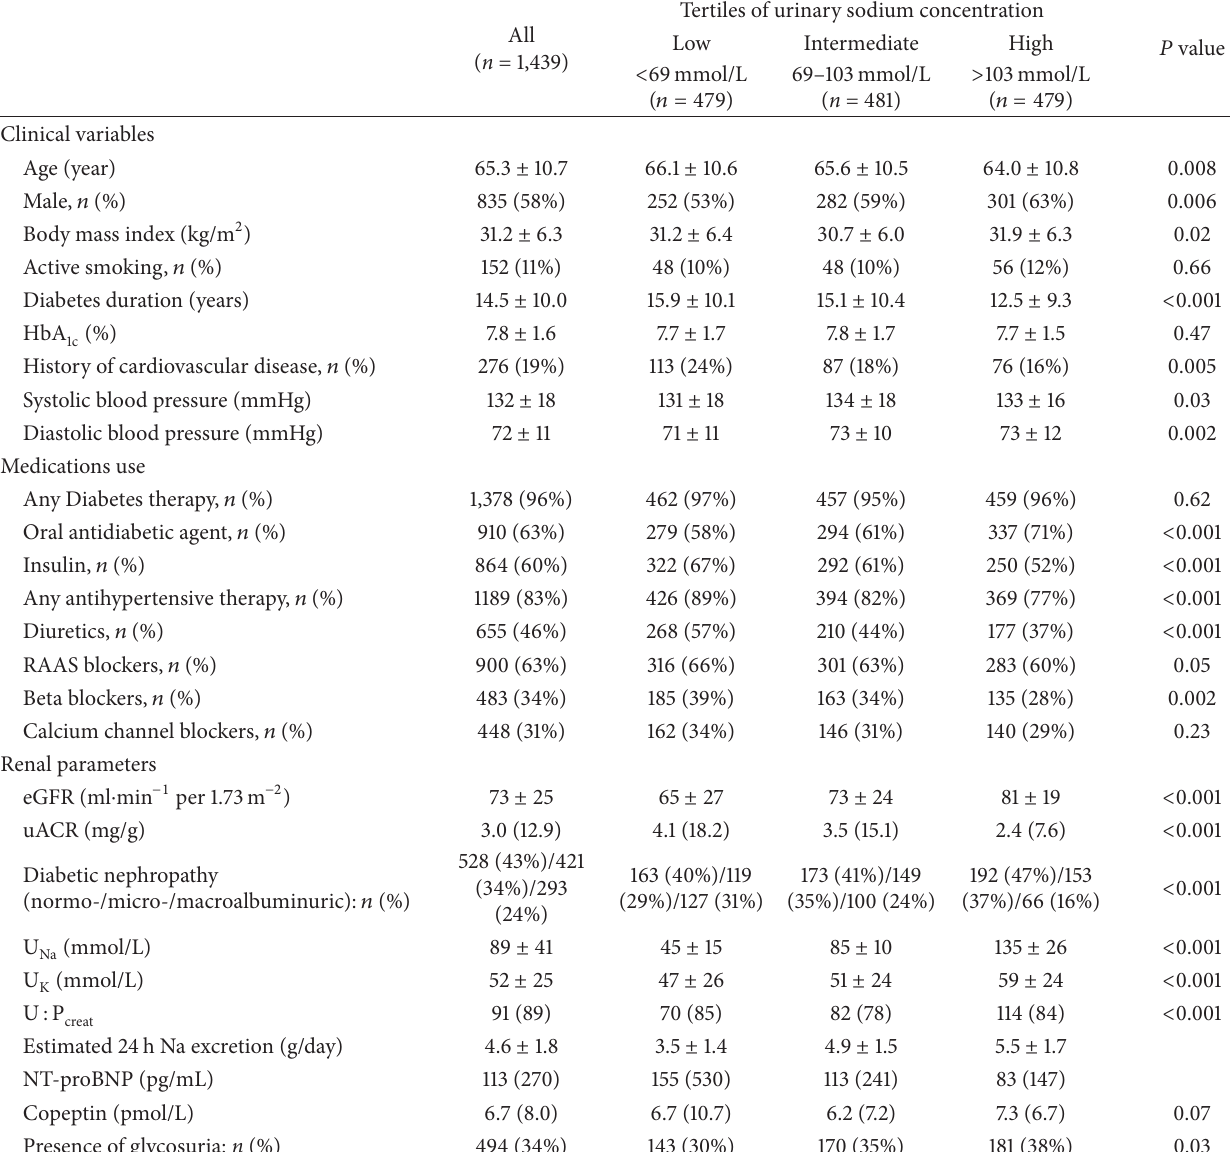
Table 1: Baseline characteristics according to tertiles of urinary sodium